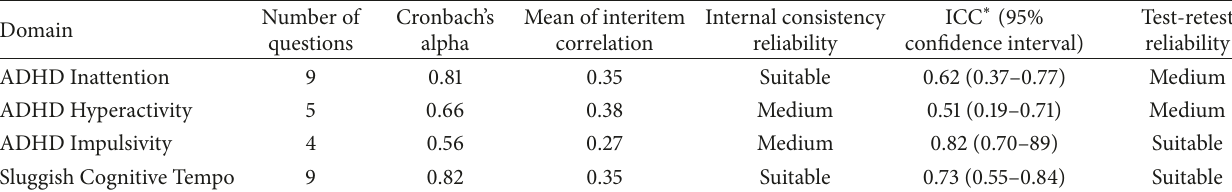
Table 2: Situation of the internal consistency and test-retest reliability for each domain.